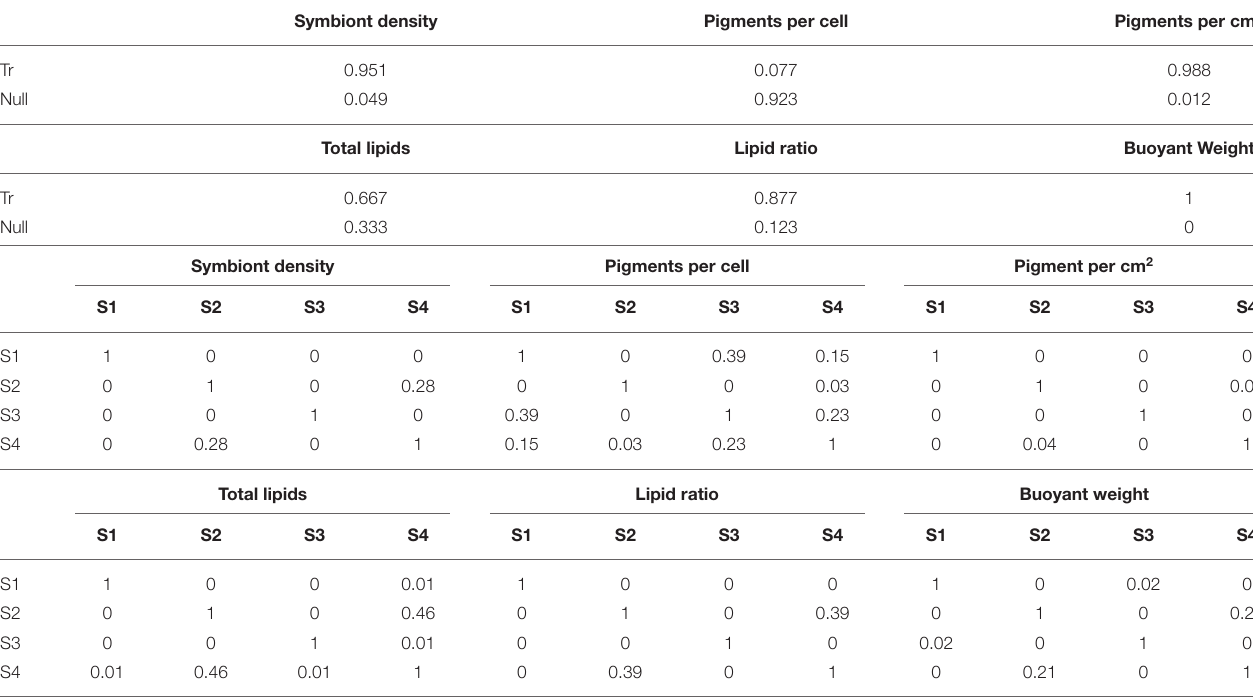
Model weights are based on AICc comparison between a model with the DLI treatment effect (DLI) and an intercept only “Null” model (Null). Post hoc comparisons were carried out using Bayesian posterior probability contrasts (calculated as the percentage overlap of posterior probabilities densities) between light scenario treatment pairs separately for each response